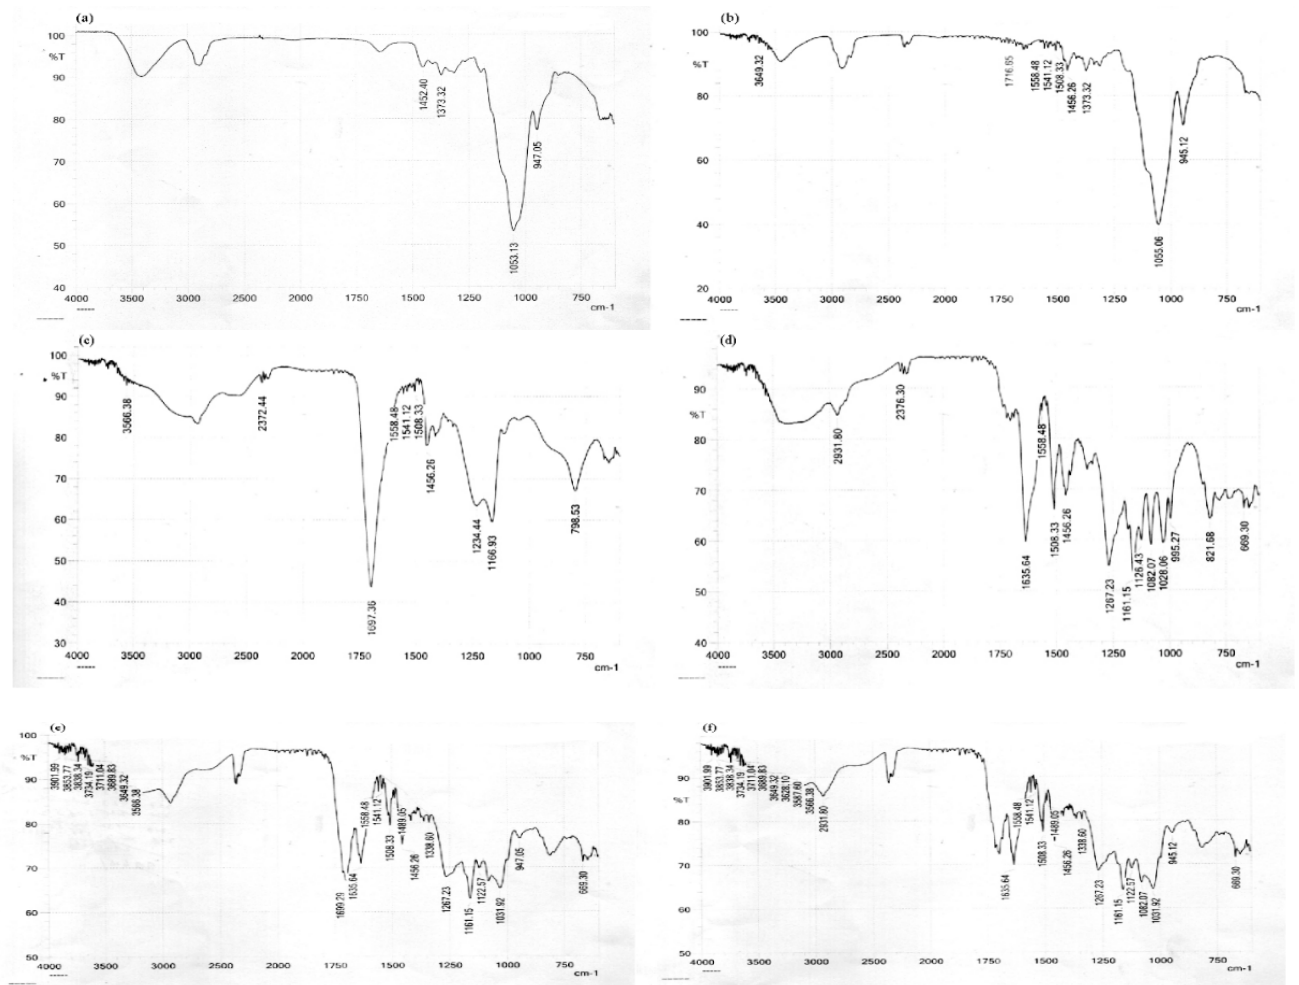
Figure 4. FTIR results of the ( a ) HPMC K4, ( b ) HPMC k15, ( c ) Carbopol 934p, ( d ) drug, ( e ) admixture and ( f ) formulation.